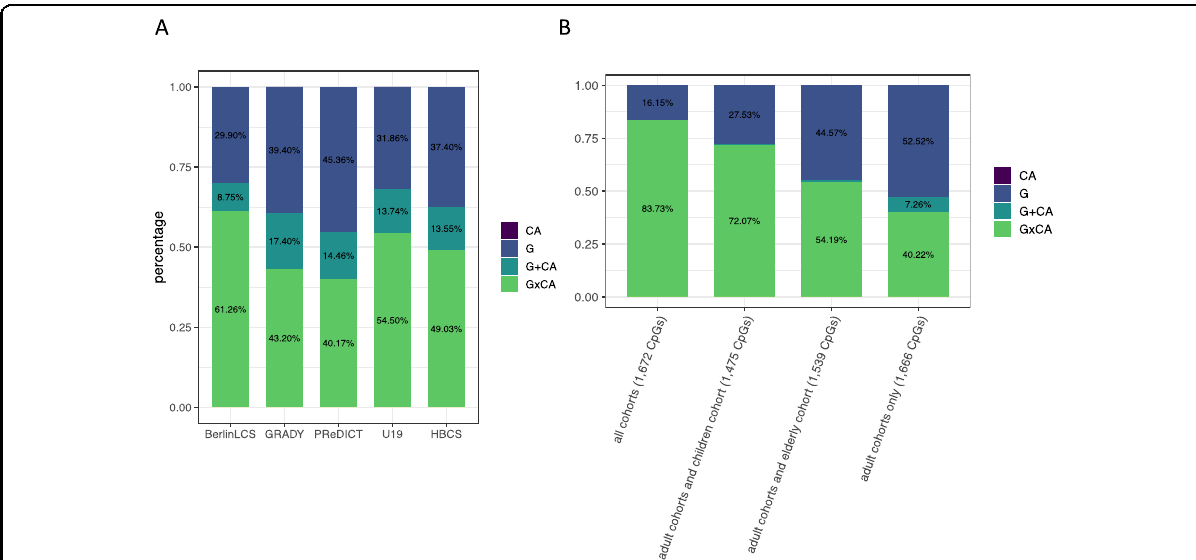
Fig. 3 Distribution of the best models explaining variation in DNAm across the fi ve cohorts. Percentage of overlapping VMPs ( n = 36,091) best explained by G, CA, G + CA, or G × CA in each cohort using the highest adjusted R 2 For HBCS, 49.03% of VMPs presented with best model G × CA, 37.40% with best model G, and 13.55% with best model G + CA, and for BerlinLCS, 61.26% of VMPs presented with best model G × CA, 29.51% with best model G, and 8.75% with G + CA ( a ). Consistency of best model explaining DNAm variability in VMPs across fi ve cohorts. Percentage of VMPs with the same model explaining variation in DNAm best overlapping between the cohorts strati fi ed by model type ( b